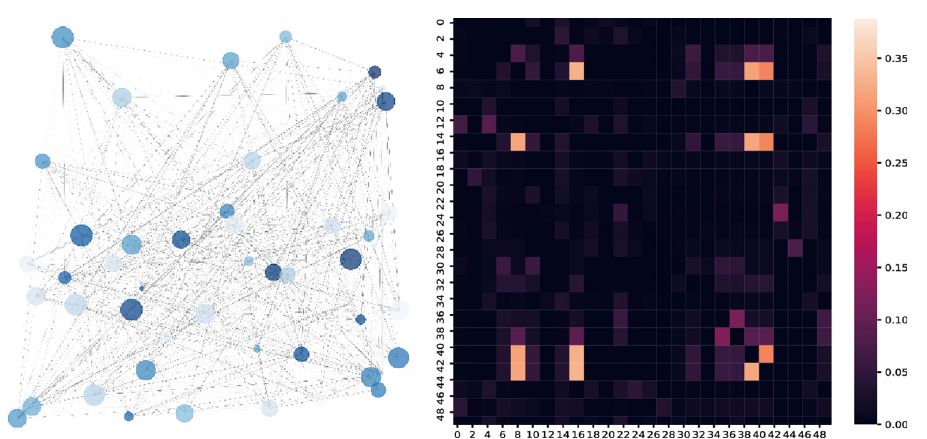
Fig 7. Example stock market news graph